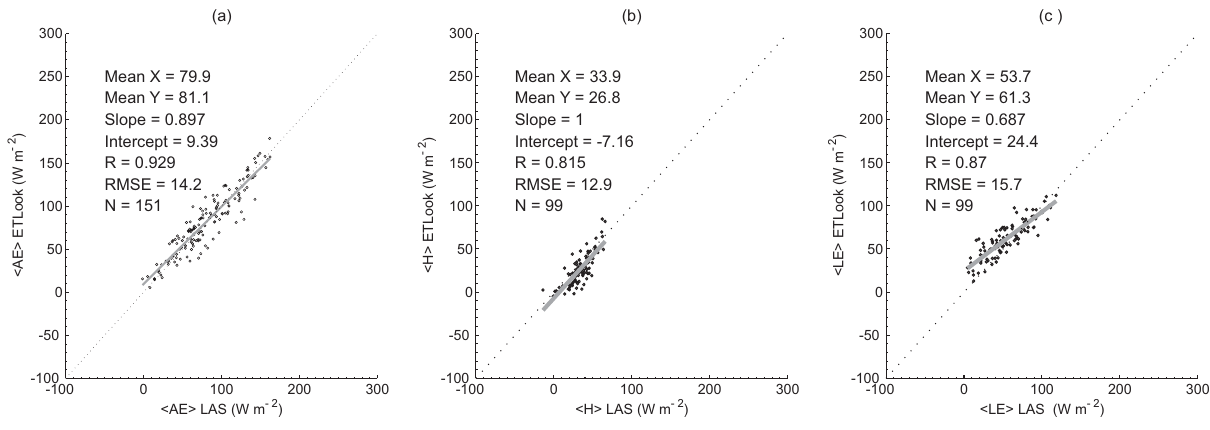
Fig. 6. Comparison for ETLook-derived and LAS-derived < AE > (a) , <H > (b) and < LE > (c) .